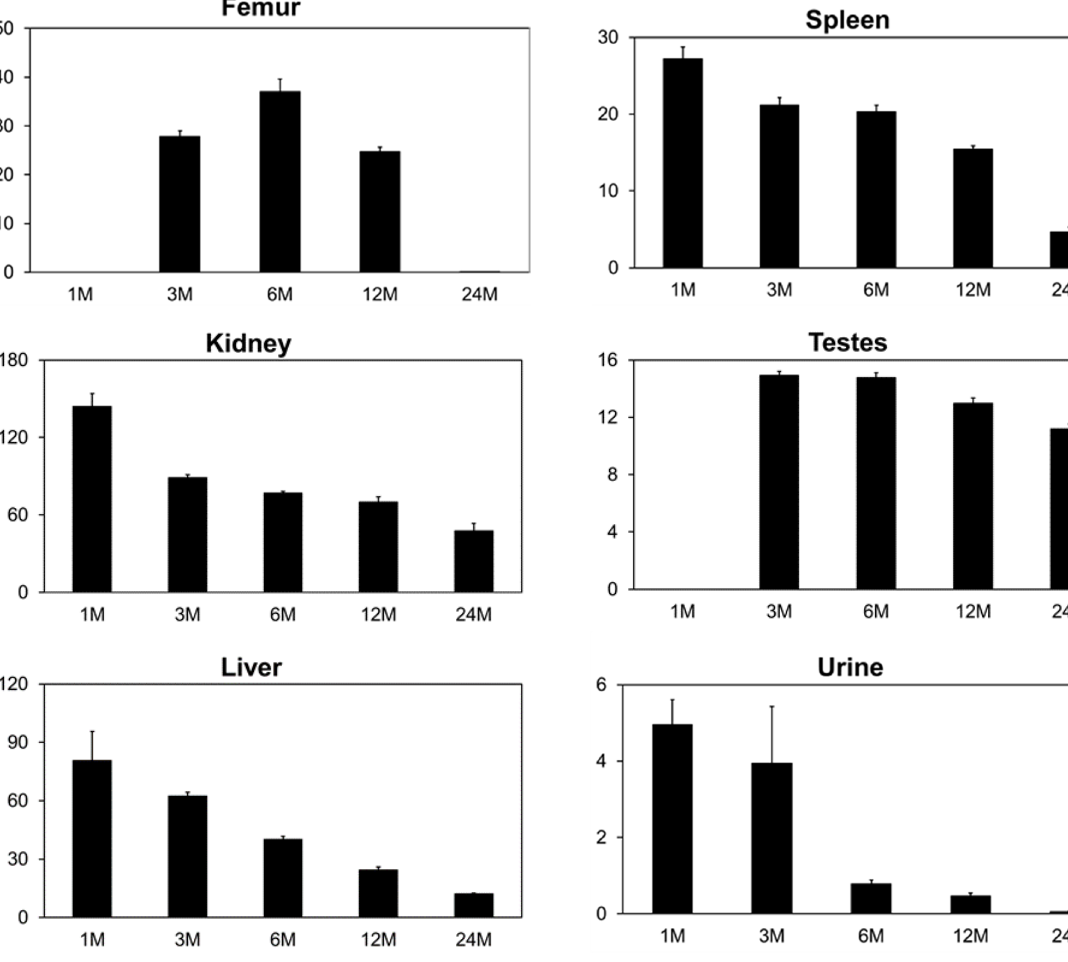
Figure 4. Tissue cobalt concentrations for WCoTa-implanted mice. The y-axis represents ng Co/gm tissue, except for “serum” (ng Co/mL serum) and “urine” (µg Co/mg creatinine). Data are the mean of 10 independent measurements. Error bars represent the standard error of the